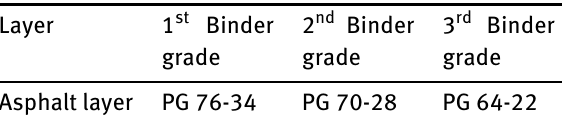
Table 7: Asphalt layer temperature through